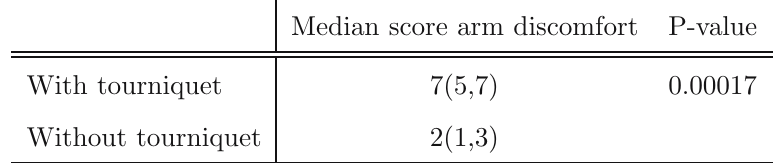
Table 2 Table comparing median arm score in patients with and without